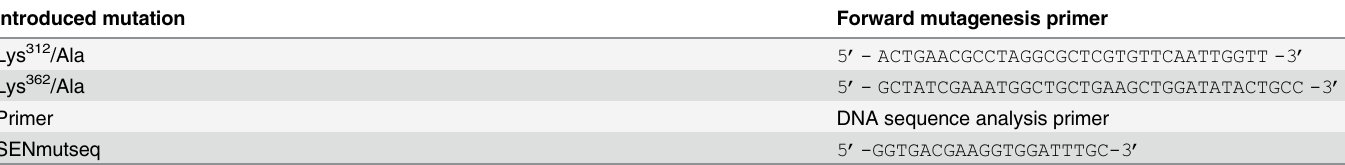
Table 1. Forward primers used for PCR construction and DNA sequence analysis of SEN site-directed